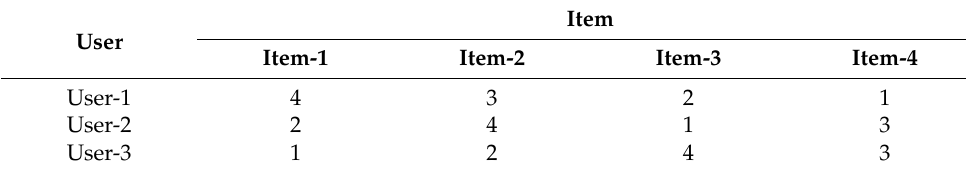
Table 3. The results of item points.